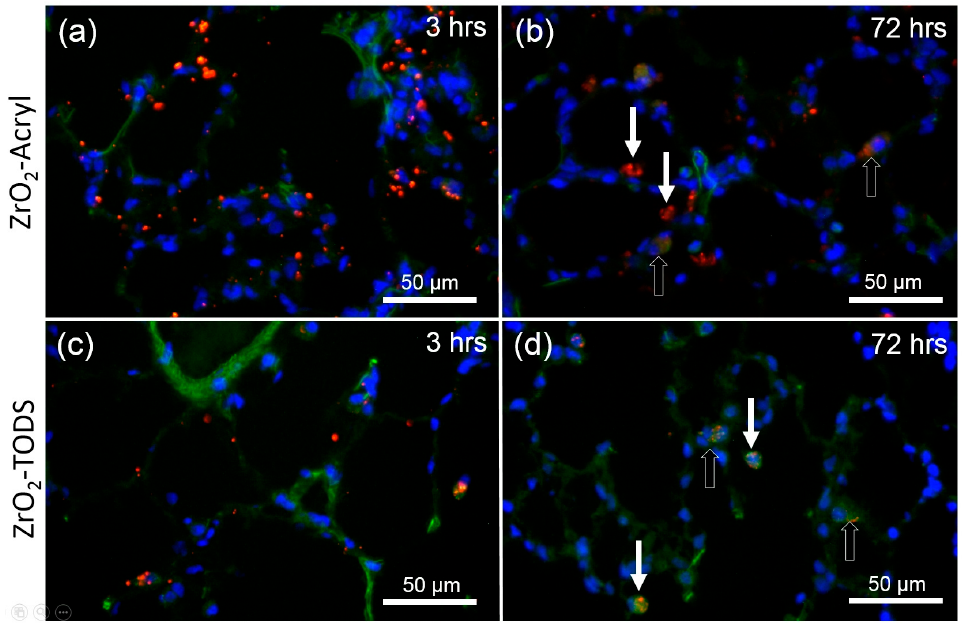
Figure 5. Early distribution of ZrO 2 NPs in the lung. Rat lungs were dosed with 1.2 mg of fluorescent ZrO 2 -Acryl ( a , b ) or ZrO 2 -TODS ( c , d ) and sections were evaluated after 3 h ( a , c ) and three days ( b , d ). Particles (red) were labeled with Texas Red NHS covalently linked to a protein corona of rat serum albumin adsorbed to nanoparticles prior to administration. Cell nuclei are stained blue with 4 ′ ,6-diamidino-2-phenylindole (DAPI). Alveolar tissue components show green autofluorescence upon illumination with blue light (488 nm). Note that 3 h post-administration, numerous fluorescent particles or agglomerates line the alveolar septae ( a , c ). After three days, red fluorescence is concentrated in phagocytic cells ( b , d ) located in alveoli or in lung epithelium (open arrows).